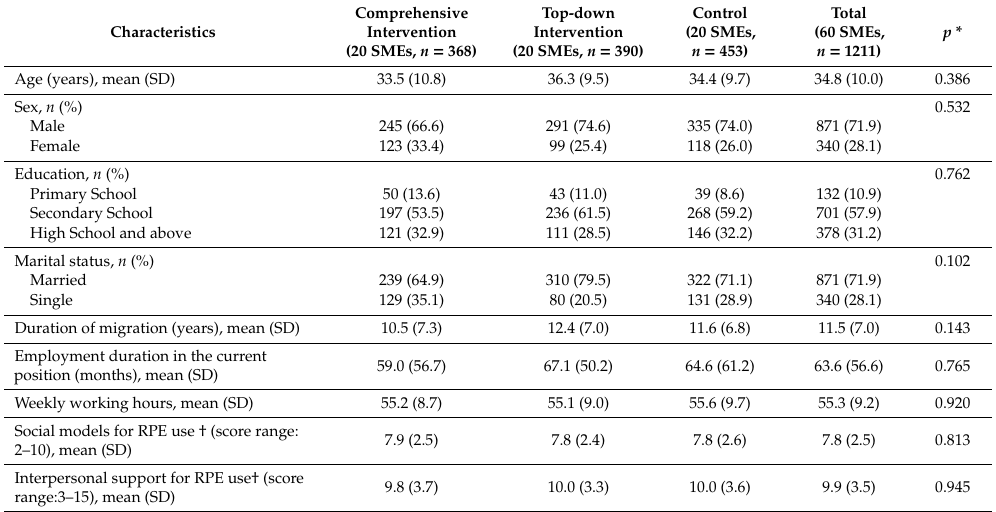
Table 2. Baseline characteristics of 1211 study participants in intervention and the control